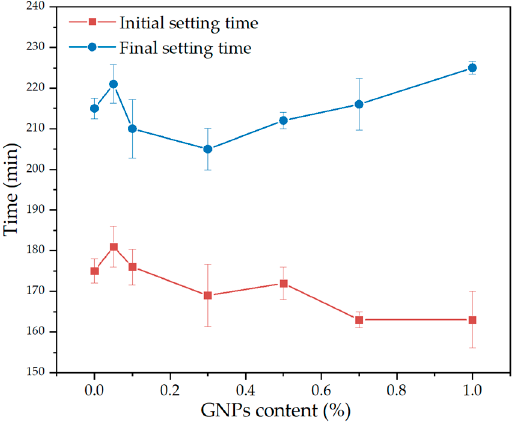
Figure 10. Influence of the dosage of GNPs on the setting time of cement paste.